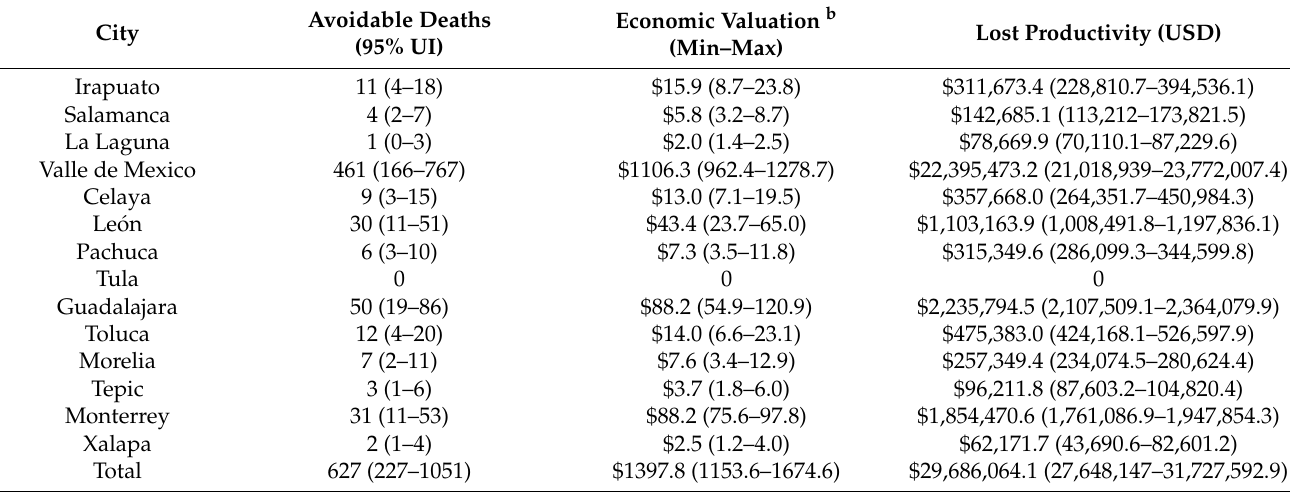
Table 2. Annual avoidable deaths from respiratory diseases associated with exposure to O 3 , 2015 a